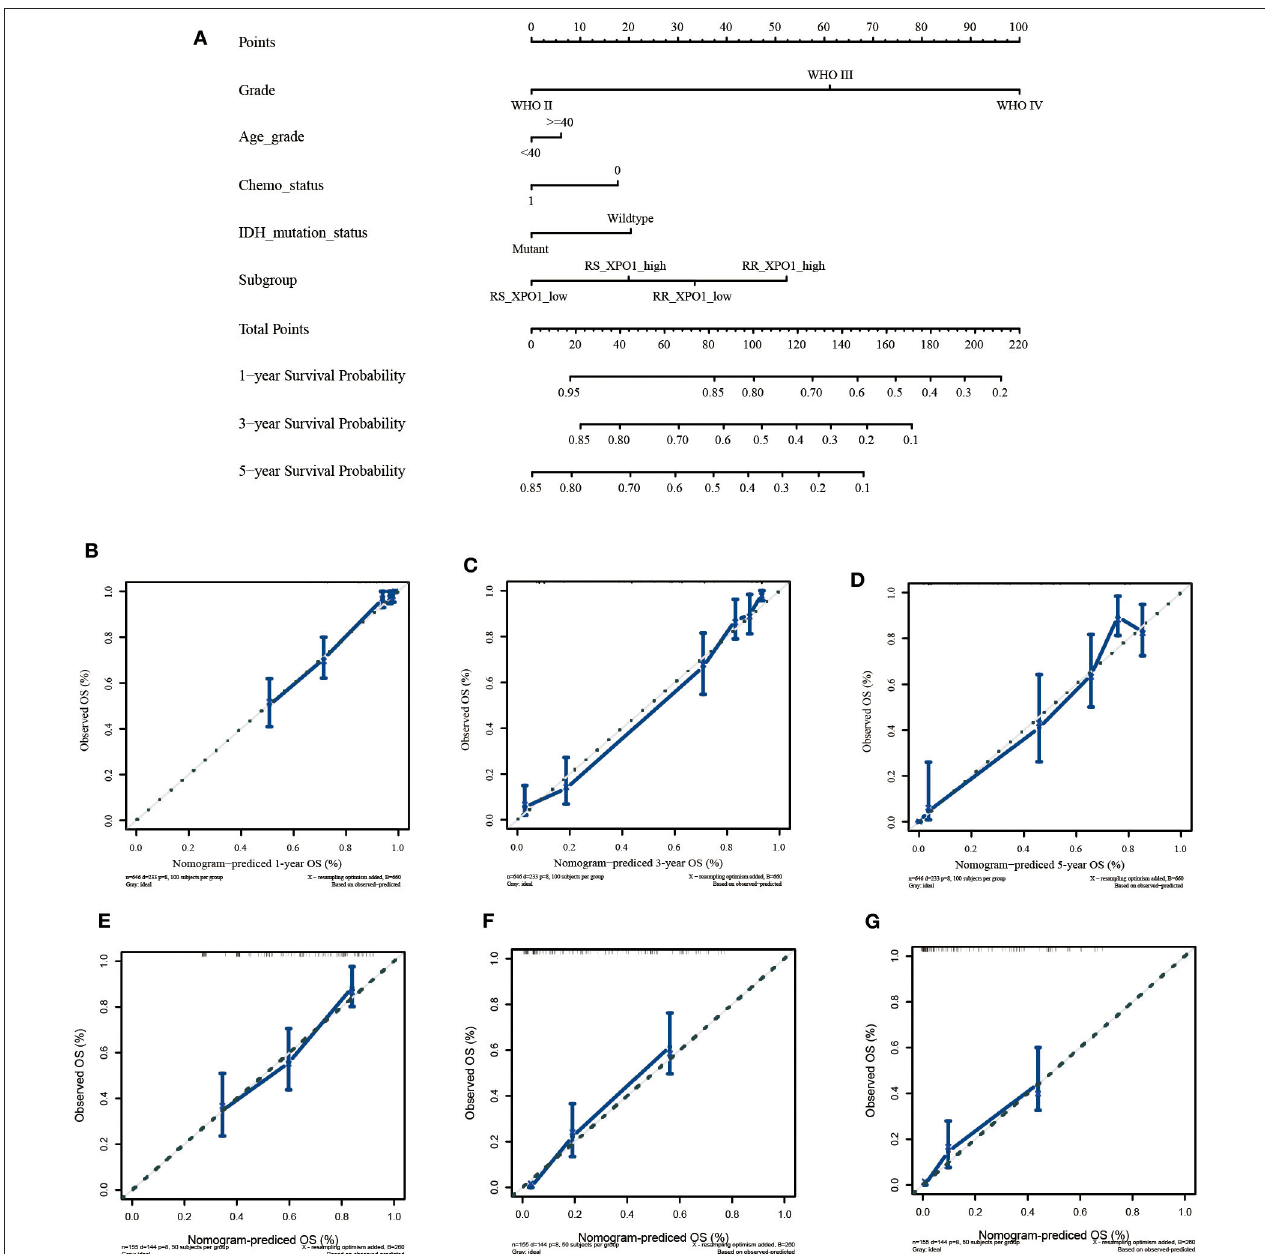
FIGURE 4 | Construction and validation of the nomogram based on clinical parameters and subgroups stratified by XPO1 expression and 31-GS. (A) Nomogram based on clinical parameters and subgroups stratified by XPO1 expression and 31-GS. (B–D) Calibration curves for predicting patient survival at 1, 3, and 5 years in the TCGA validation cohort. (E–G) Calibration curves for predicting patient survival at 1, 3, and 5 years in the GEO validation cohort.